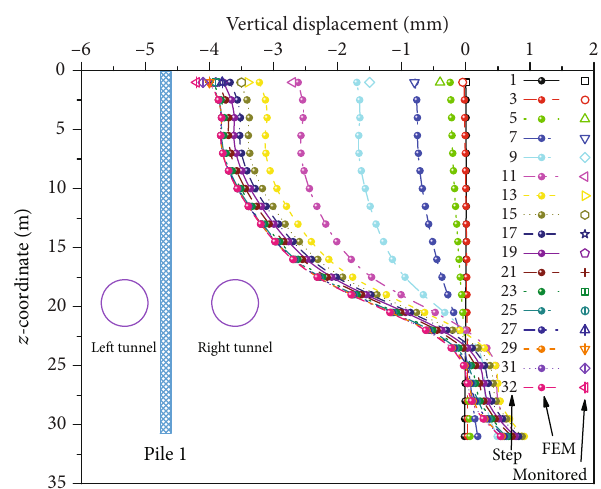
Figure 11: Vertical displacements of Pile 1 at di ff erent tunneling steps.